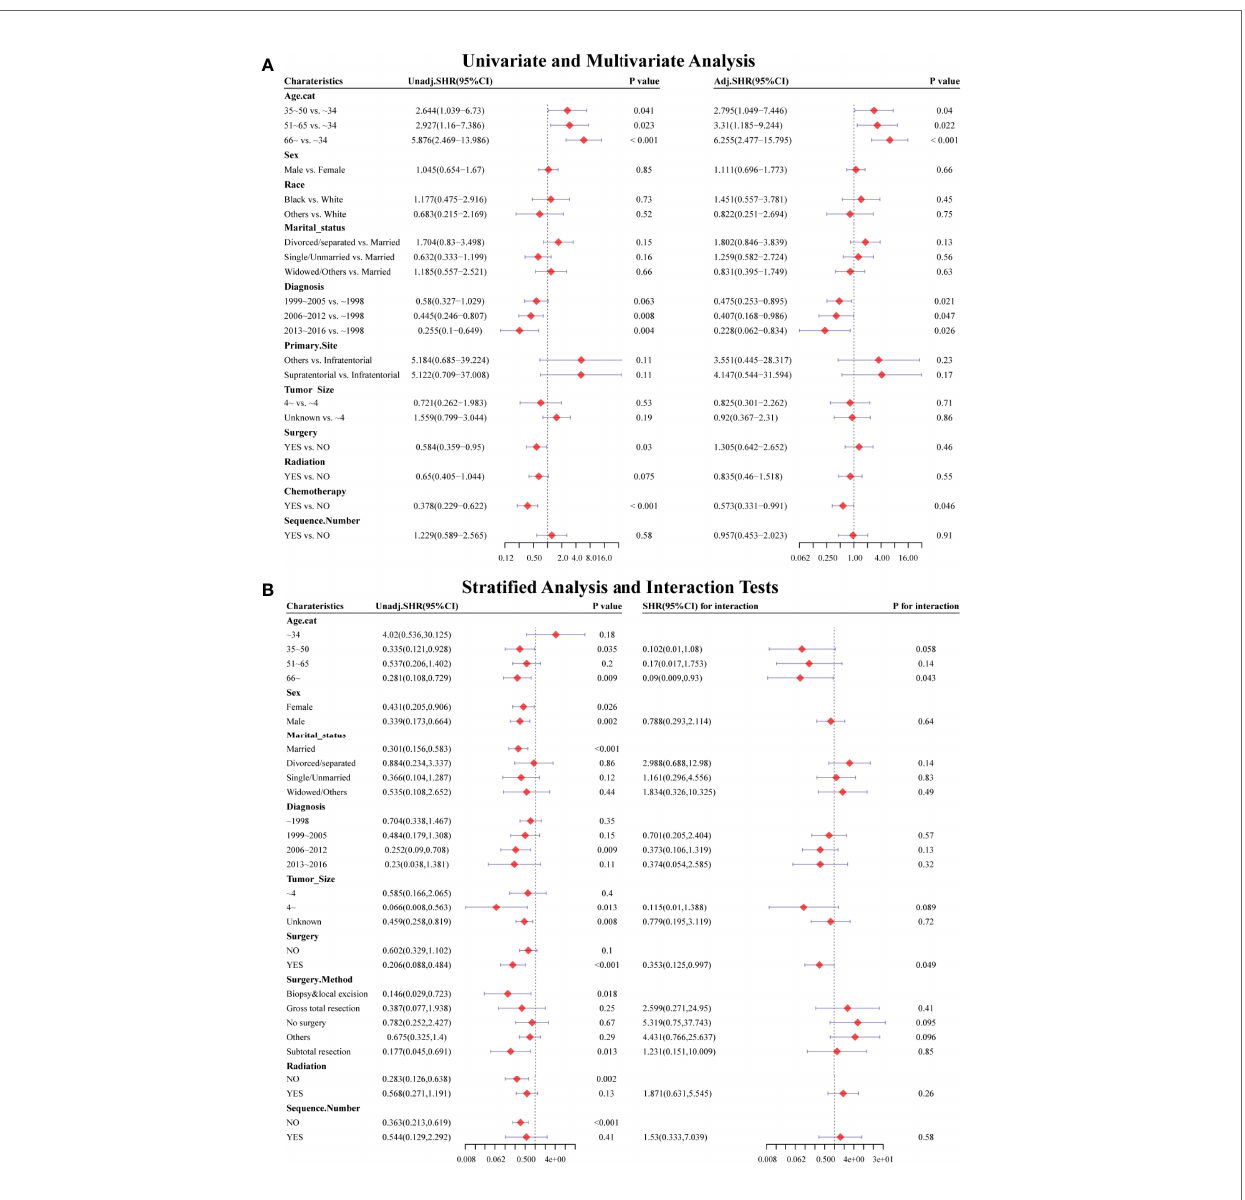
FIGURE 4 | Forest plots showed the results of ( A , left) univariable and ( A , right) multivariable analysis based on the competing risk regression model. Forest plots showed the results of ( B , left) strati fi ed analysis and ( B , right) interaction tests based on the competing risk regression model. SHR: subdistribution hazard ratio; CI, con fi dence